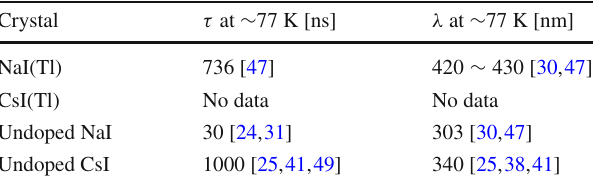
Table 4 Scintillation wavelength λ and decay time τ of Tl-doped and undoped NaI, CsI crystals at liquid nitrogen temperature